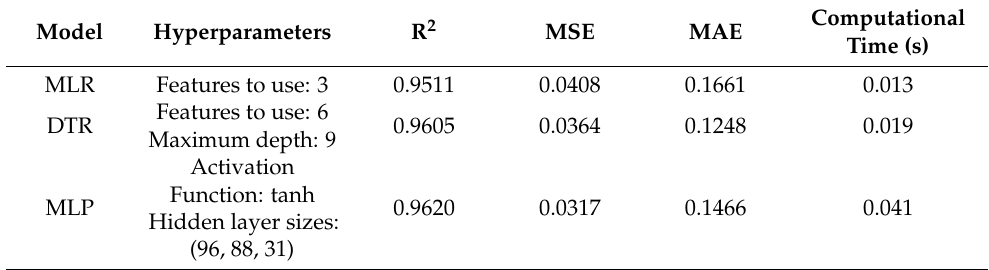
Table 6. Tuned hyperparameters and performance parameters for MLR, DTR, and MLP regressors.